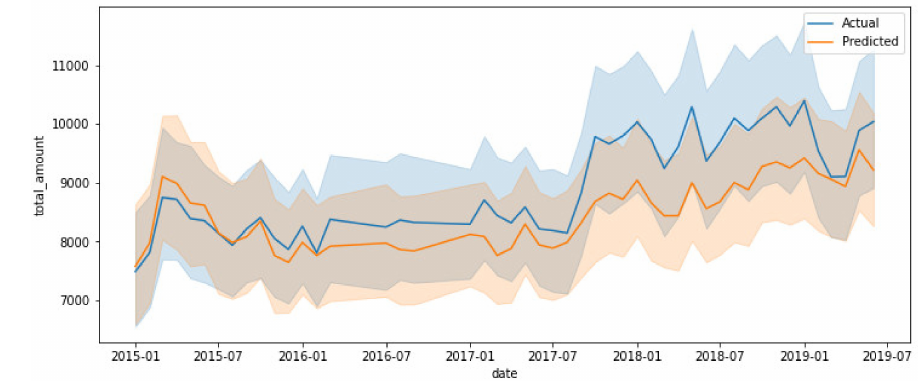
Figure 6. Artificial Neural